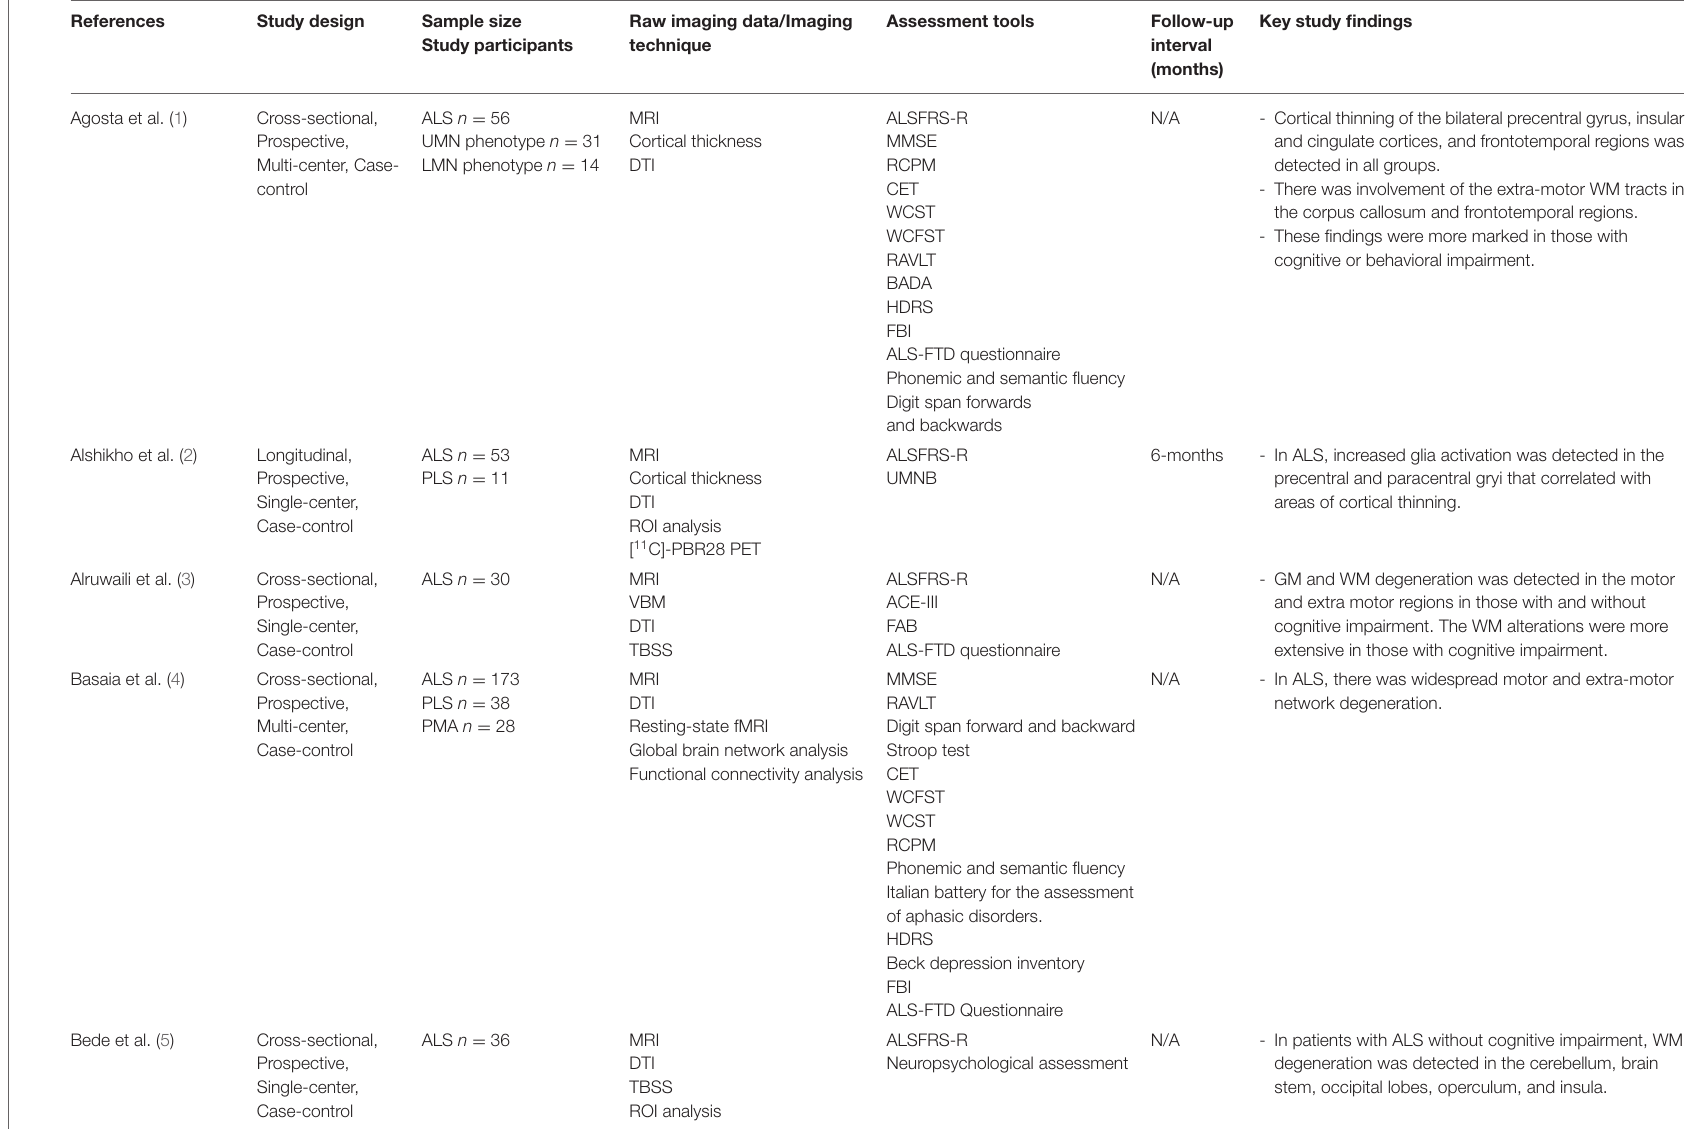
TABLE 1 | Selection of original neuroimaging research articles in ALS since 2015 with more than 30